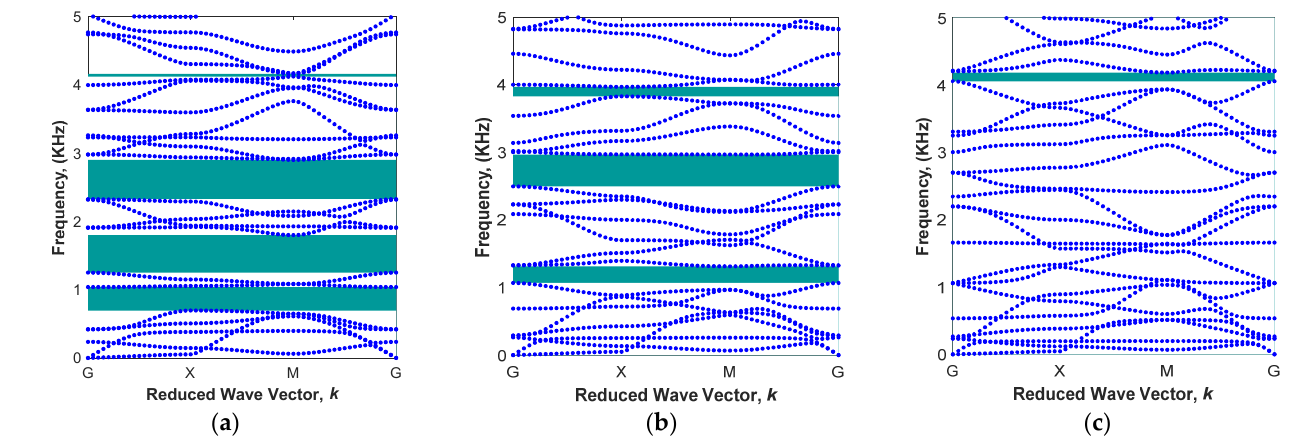
Figure 4. Various band structures in different radiuses of cylindrical core in the fixed arm angle θ = 0 and iron volume fraction of 13.94%: ( a ) L / R = 5; ( b ) L / R = 8; ( c ) L / R = 13.